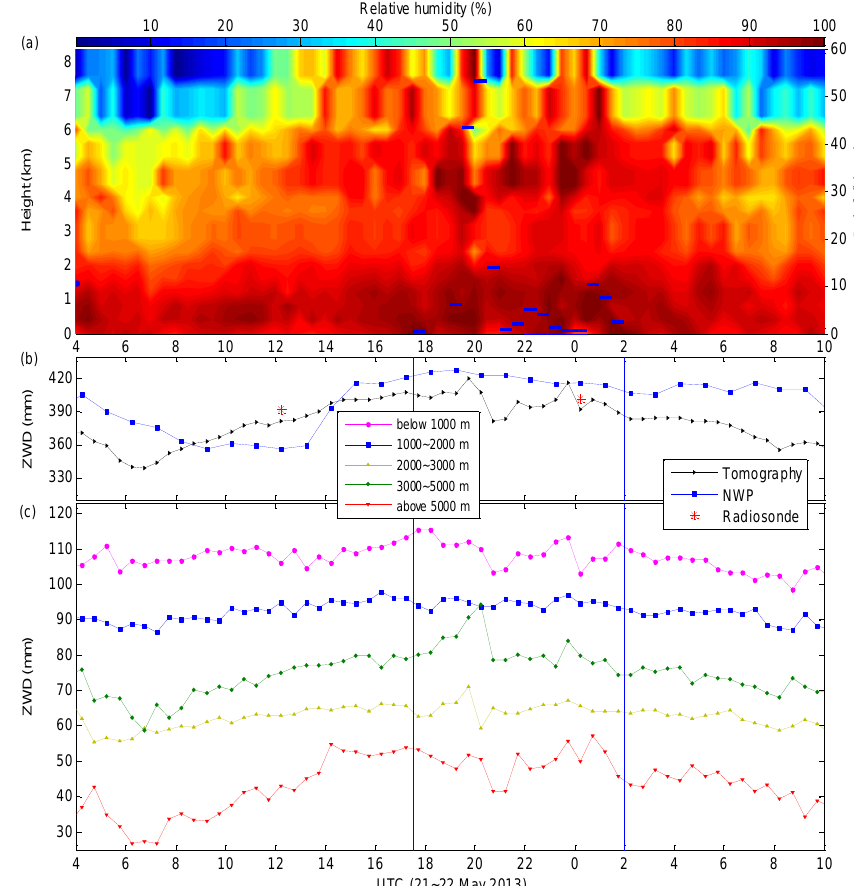
Figure 7. Evolution of tomographic relative humidity profiles (a) , total ZWD (b) and ZWD at various layers (c) every 30min from 21 May 04:00UT to 22 May 2013 10:00UT over the HKO weather station. The blue lines in panel (a) show the gauged rainfall within each 30min, and their values correspond to the right vertical axis. Panel (c) presents the ZWD below the height of 1000m (pink curve with circle), ZWD between 1000 and 2000m (blue curve with square), ZWD between 2000 and 3000m (yellow curve with triangle), ZWD between 3000 and 5000m (green curve with rhomb) and ZWD above the height of 5000m (red curve with inverse triangle).